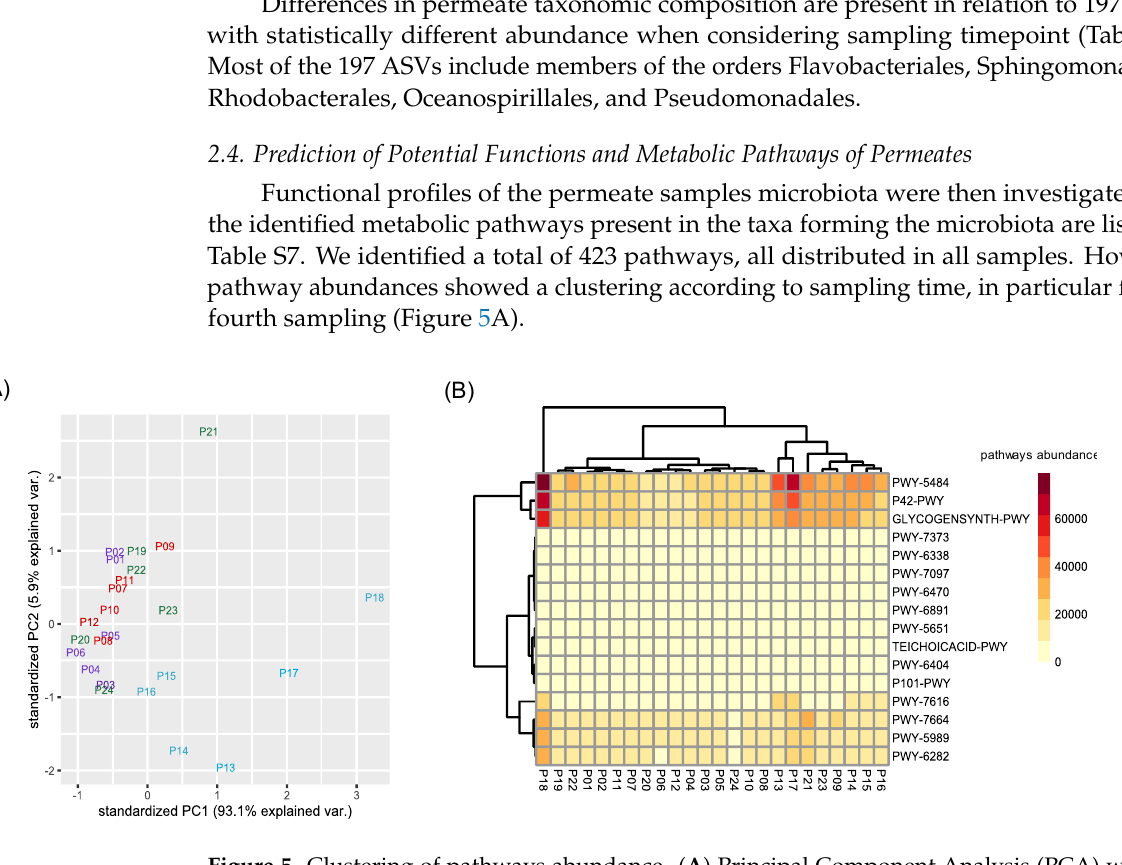
Figure 5. Clustering of pathways abundance. ( A ) Principal Component Analysis (PCA) was per- formed considering the predicted functional abundances of all identified pathways. In violet per- meates of the second sampling, in red for the third, in blue for the fourth, and in green for the fifth. ( B ) Heatmap considering only the top three pathways that differentiate each contrast between varieties returned by SIMPER test. Codes of represented pathways refer to the MetaCyc Metabolic Pathway Database.